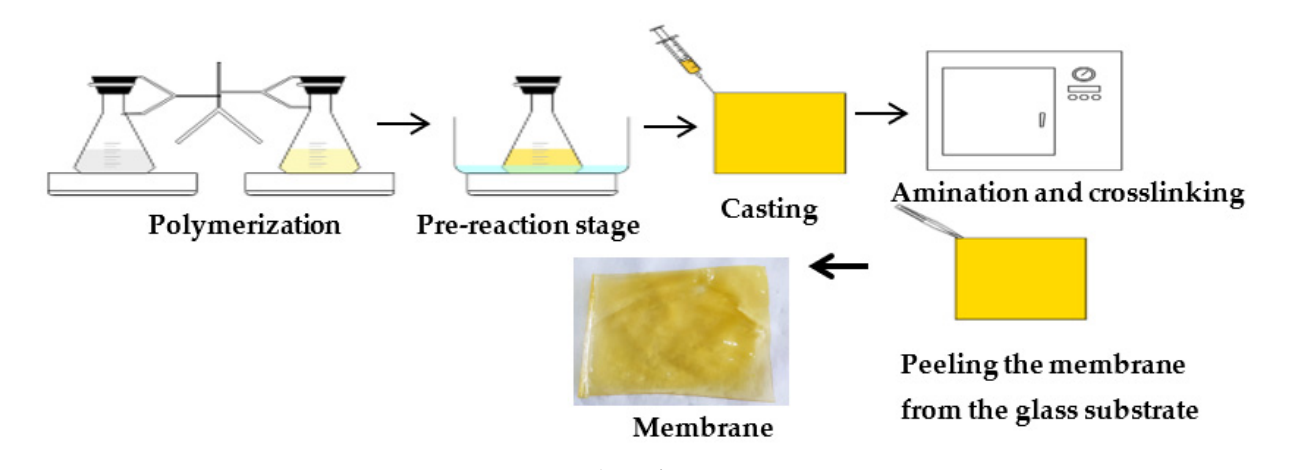
Figure 2. Preparation procedure of AEMs. Blend ratio ( σ ) is defined as the mass ratio of PECH to PAN and expresses the active polymer ratio per unit inert polymer by mass as explained in Equation (1): m PECH σ = (1) m PAN DABCO is added to the casting solution for amination and cross-linking for PECH to re- act with chloromethyl groups to create the specific positive charge required for ion exchange. The excess diamine ratio ( ν ), shows the molar ratio of the amine component in DABCO ( m d , mmol/g diamin) and chloromethyl groups in PECH solution ( m p , mmol/g—CH 2 Cl). This expression also indicates how many chloromethyl groups are used in the amine (DABCO) amount as explained in Equation (2):